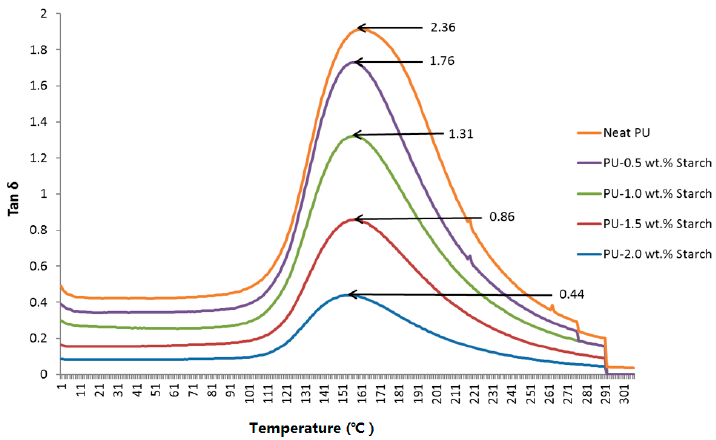
Figure 9. Loss tangent of neat PU and PUS composites.